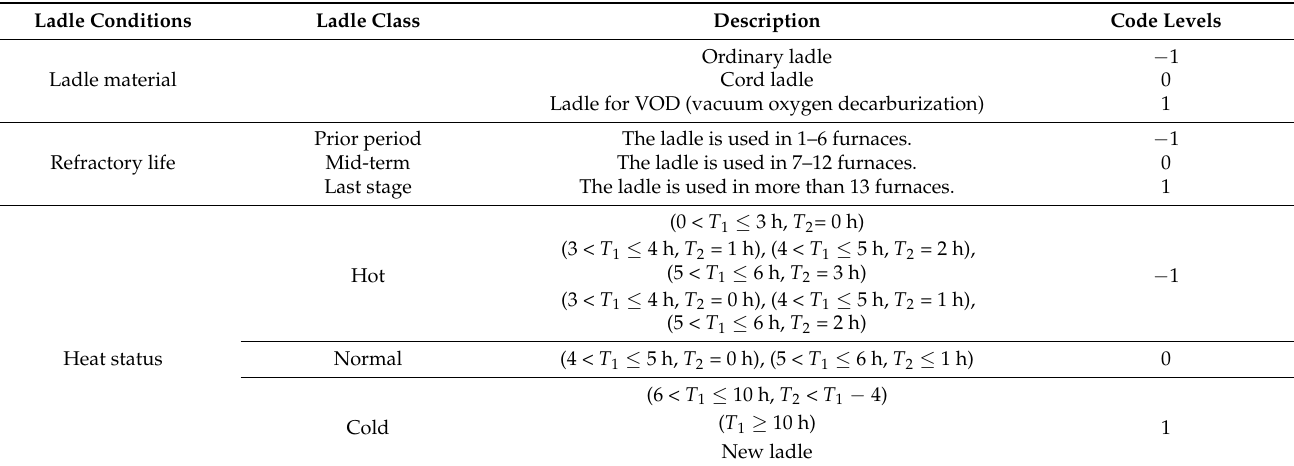
Table 1. The division of ladle conditions.